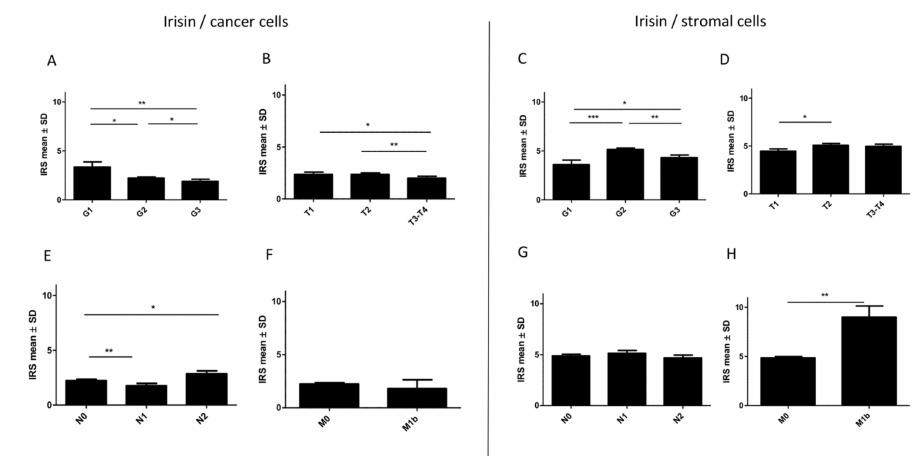
Figure 6. Comparison of irisin expression levels in NSCLC cells according to the grade of malignancy ( A ), tumour size ( B ), lymph node status ( E ) and metastases ( F ). Comparison of expression levels of irisin in stromal cells of NSCLC according to the grade of malignancy ( C ), tumour size ( D ), lymph node status ( G ) and metastases ( H ) * p ≤ 0.05, ** p ≤ 0.005, *** p ≤